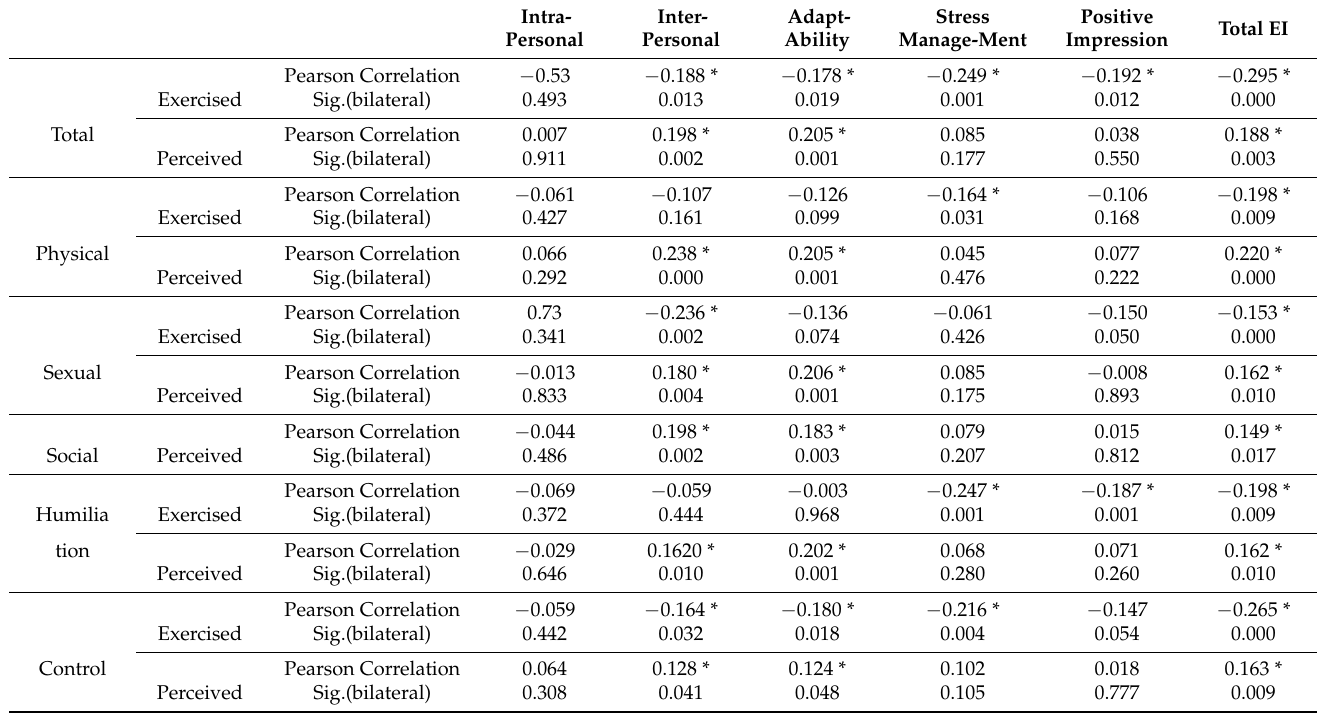
Table 2. Relation between Violence and Emotional